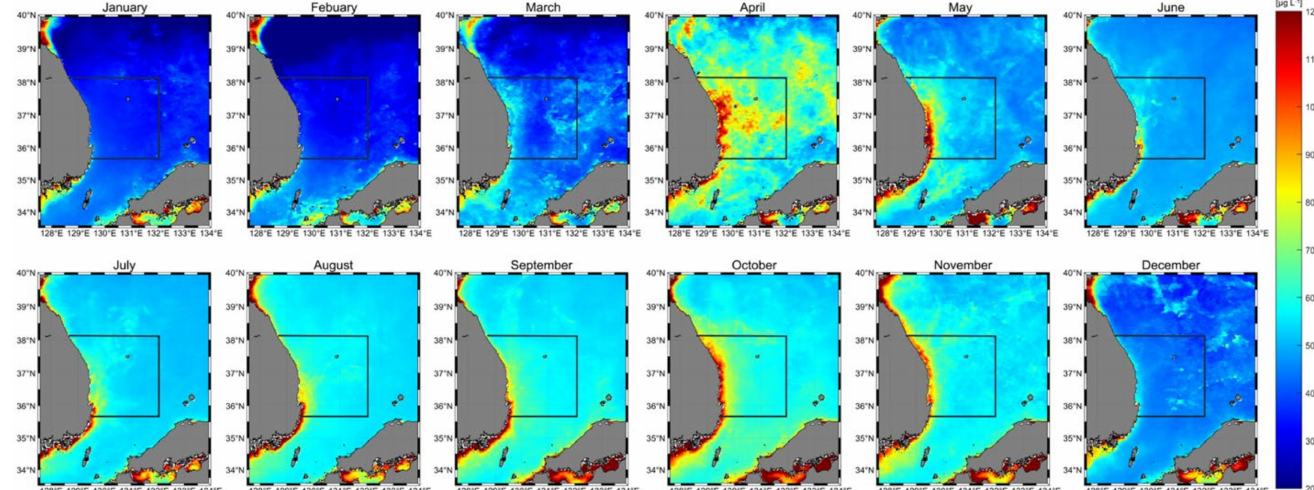
Figure 6. Climatological monthly averaged distribution of protein concentration of phytoplankton based on the MODIS- derived protein concentration from 2003 to 2019 in the